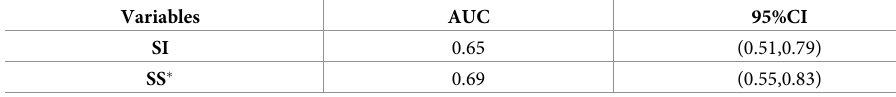
Table 3. Analyses of receiver operating characteristic curves.